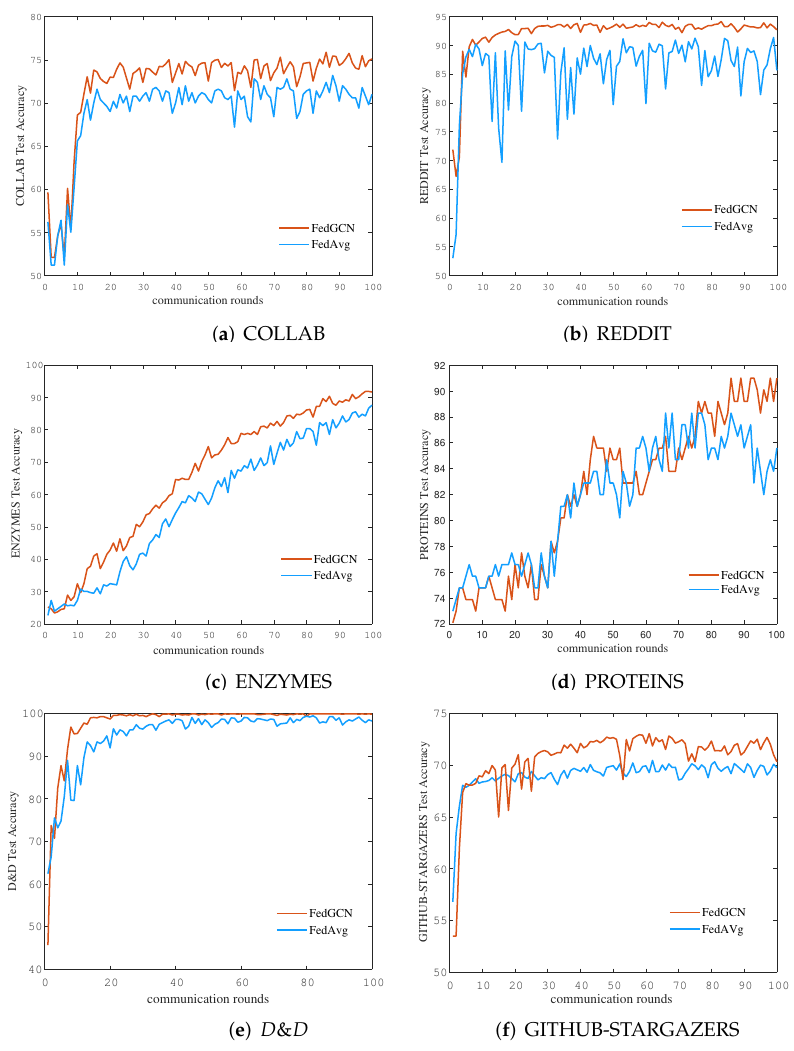
Figure 7. Accuracy experiment of the FedGCN algorithm on six datasets. Figure 8 shows the accuracy experiments of the three models on the six datasets— COLLAB, REDDIT, ENZYMES, PROTEINS, D & D , and GITHUB-STARGAZERS (epochs corresponding to FedGCN are the communications rounds between the local model and the global model). It can be clearly seen that FedGCN has a high accuracy rate regardless of the dataset. It is obvious that FedGCN has high accuracy with respect to any dataset, and the training process is relatively stable compared with the other two GCN models. There is no significant sign of decline in accuracy. The accuracy of the GCN model is also relatively higher compared to the newer GIN algorithm. FedGCN adds a TopK pooling layer, a full connection layer, and cross-layer fusion, which can well extract node features, obtain relatively superior local model parameters, and prepare for global